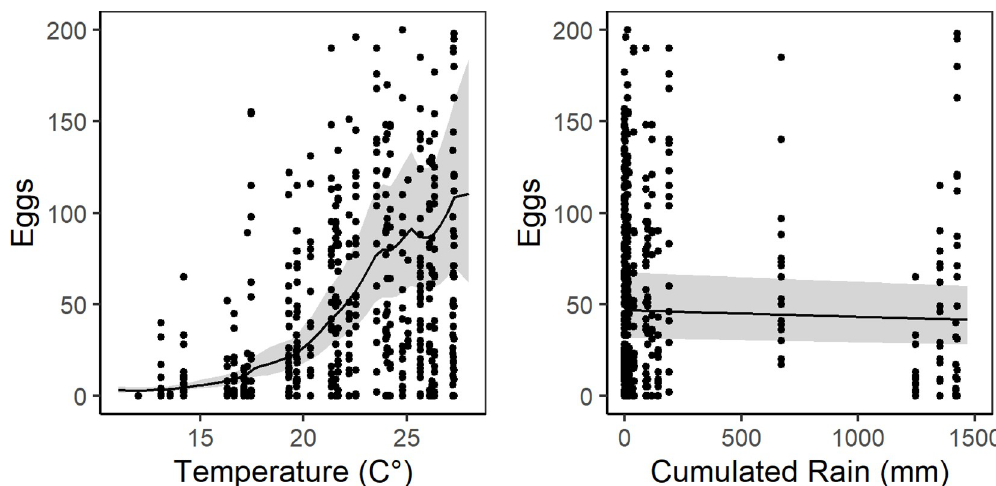
Fig 1. GAMM posterior predictive values of Ae . albopictus eggs/ovitrap/week on Procida Island. Left panel = temperature dependent mean value of eggs/ovitrap/week. Right panel = rain dependent mean value of eggs/ovitrap/week. Solid lines = GAMM posterior mean value of eggs/ovitrap/week. Grey areas = 95% credible interval. Black dots = observed values of eggs/ovitrap/week. y-axis = number of eggs/ovitrap/week. x-axis (left panel) = weekly averaged temperature. x-axis (right panel) = weekly accumulated precipitation.